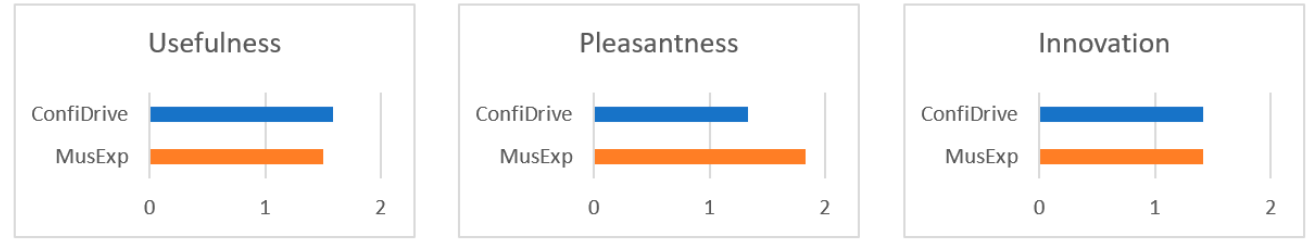
Figure 14. Results after testing for the perceived usefulness, pleasantness, and innovation of the ConfiDrive and MusExp apps, plotted on a Likert scale where 0 is neutral, 1 positive, and 2 very positive.